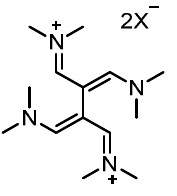
Figure 1. bis-trimethinium salt.